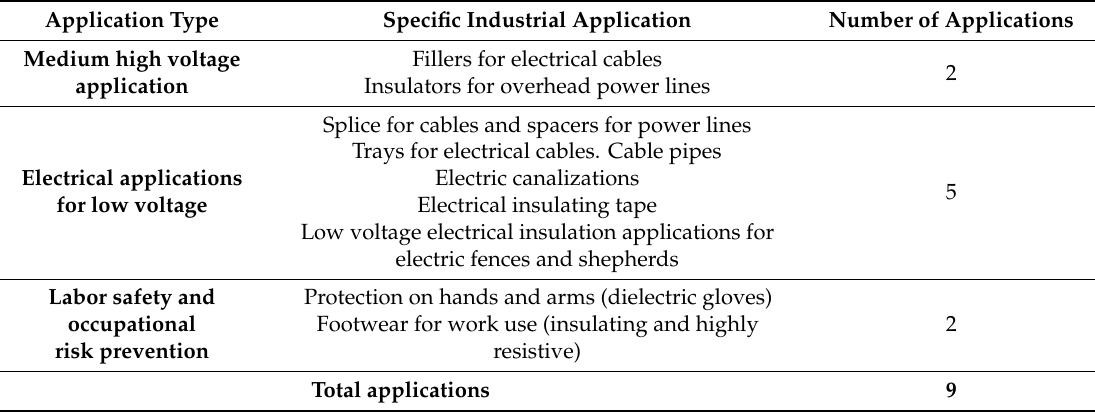
Table 6. Selected applications to compare values from the UNE / IEC standards versus measured data.